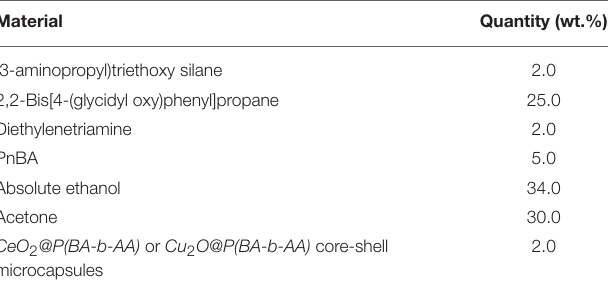
TABLE 2 | The conditions used in the preparation of the epoxy solution. Material Quantity